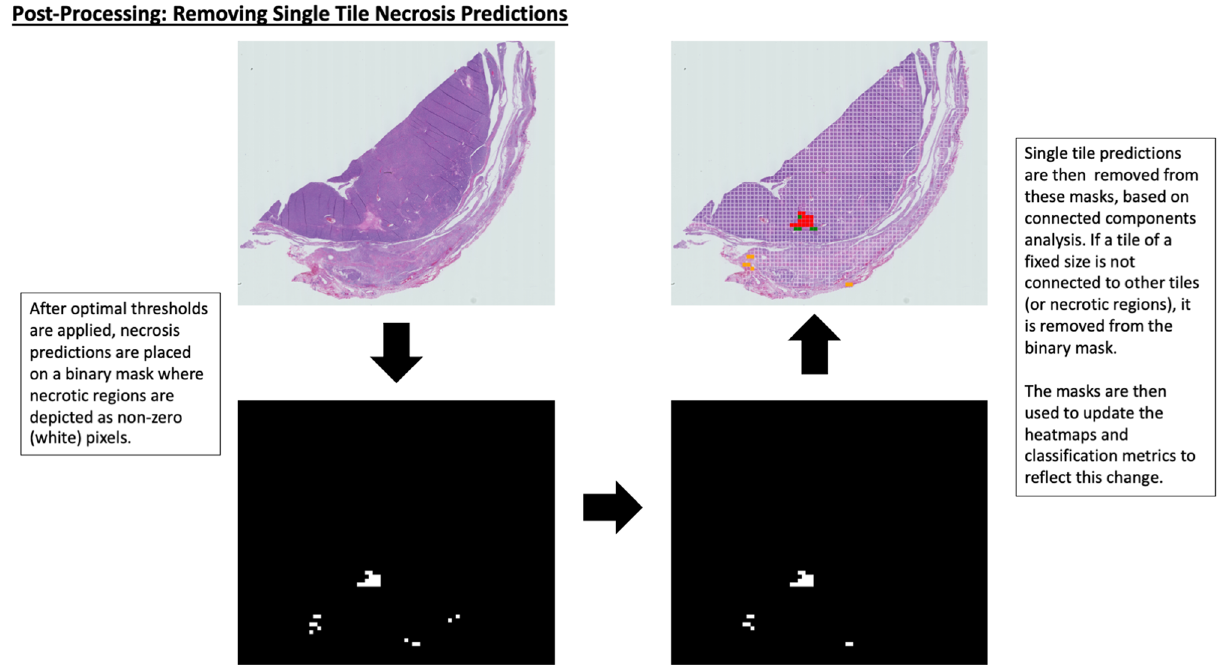
Figure 5. The post-processing step to remove predicted single necrosis tiles is depicted. The necrosis predictions are applied to a binary mask which is a downsized binary map of the original WSI, by a factor of 32x, for computational efficiency. Connected components analysis is subsequently performed, where if a tile of a fixed size (in this case an area of 32 pixels squared) is not connected to other tiles, horizontally, vertically, or diagonally, it is removed from the mask. Final predictions are updated based on using these binary